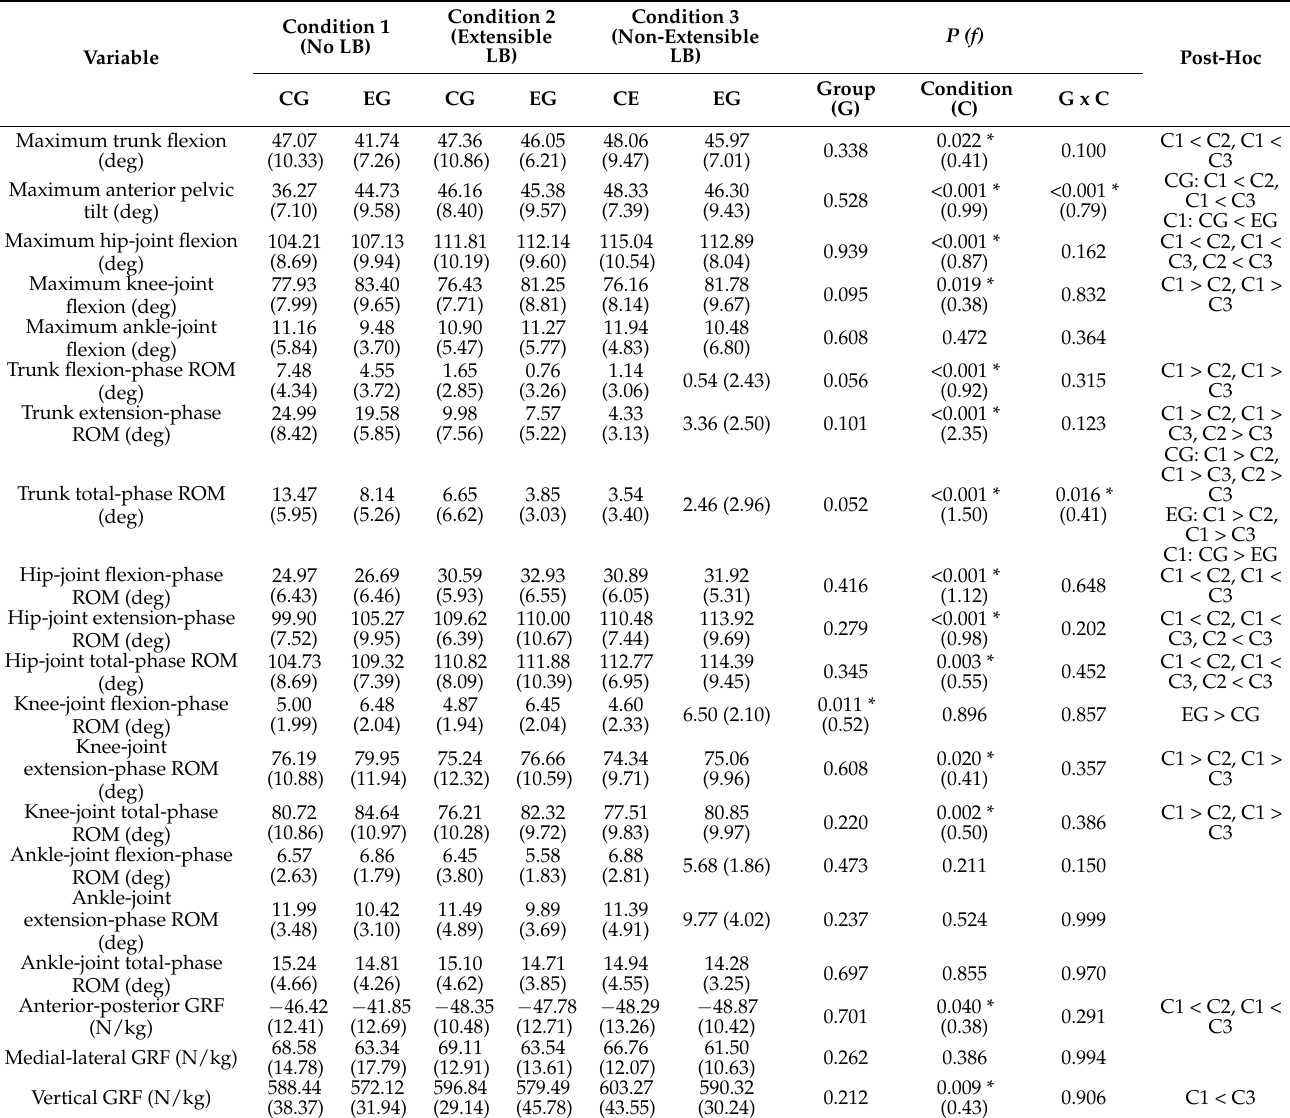
Table 2. Analysis of biomechanical variables of the sit-to-stand movement according to the lumbar belt conditions in the experimental and control